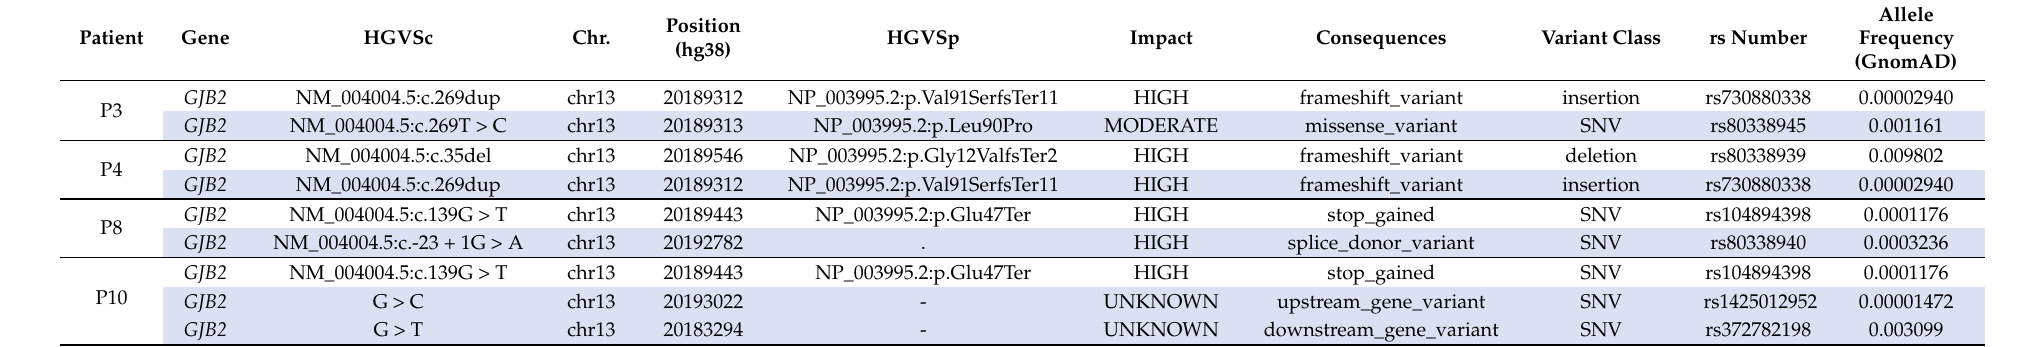
Table 2. DFNB1 mutations detected by